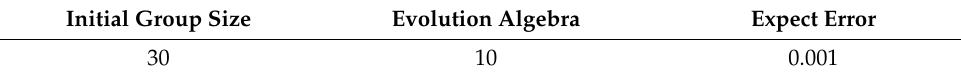
Table 8. GA initialization